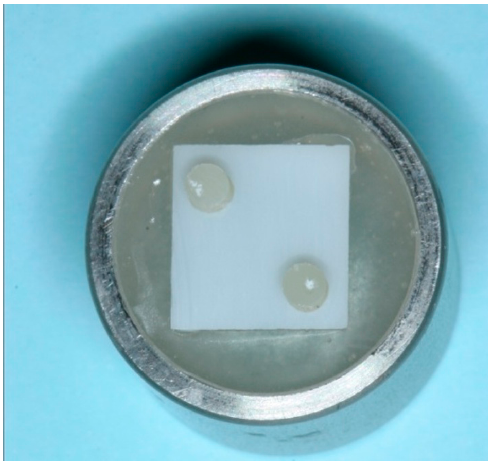
Figure 1. Bonded composite tubes on the embedded zirconia specimen using the resin cements.